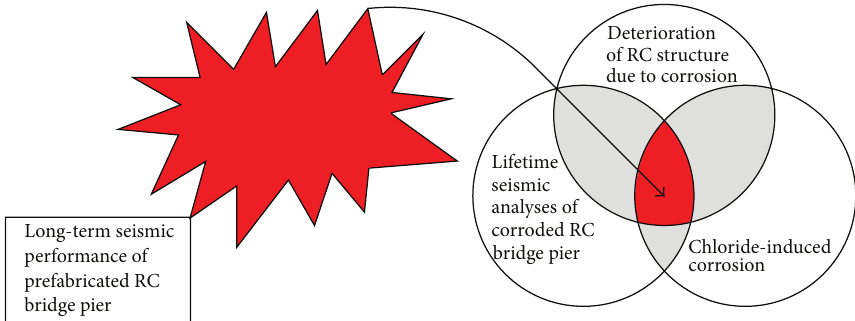
Figure 1: Outline of long-term seismic performance of corroded structures.